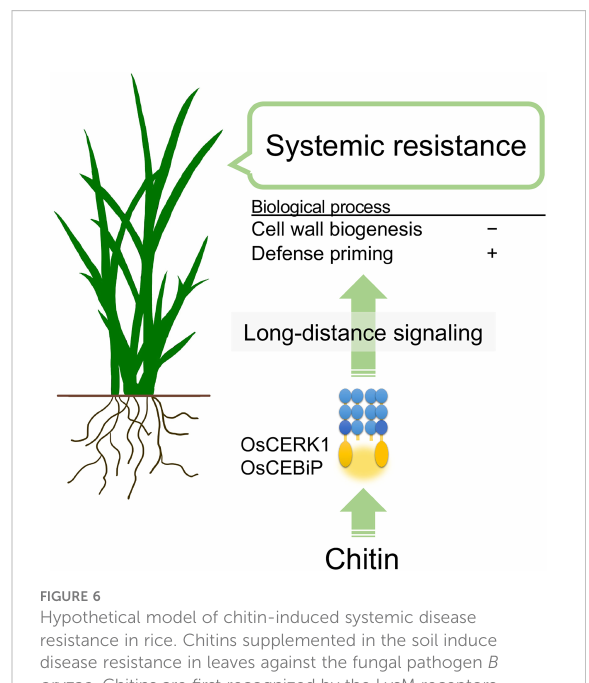
FIGURE 6 Hypothetical model of chitin-induced systemic disease resistance in rice. Chitins supplemented in the soil induce disease resistance in leaves against the fungal pathogen B oryzae . Chitins are fi rst recognized by the LysM receptors OsCERK1 and OsCEBiP in roots. Then, long-distance signalling initiated in the roots perturbs cell-wall biogenesis and upregulates defence priming-related genes in leaves, inducing disease